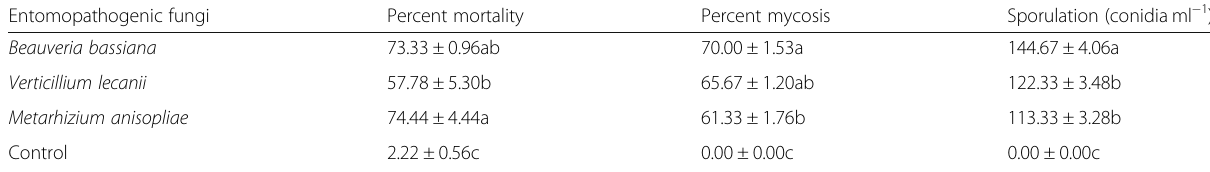
Table 1 Percentage mortality of the third instar of Cnaphalocrosis medinalis larvae and percentage of mycosis and sporulation from their cadavers assayed with the entomopathogenic fungi, Beauvaria bessiana , Verticelium lecanii , and Metarhizium anisopliae in in vitro Entomopathogenic fungi